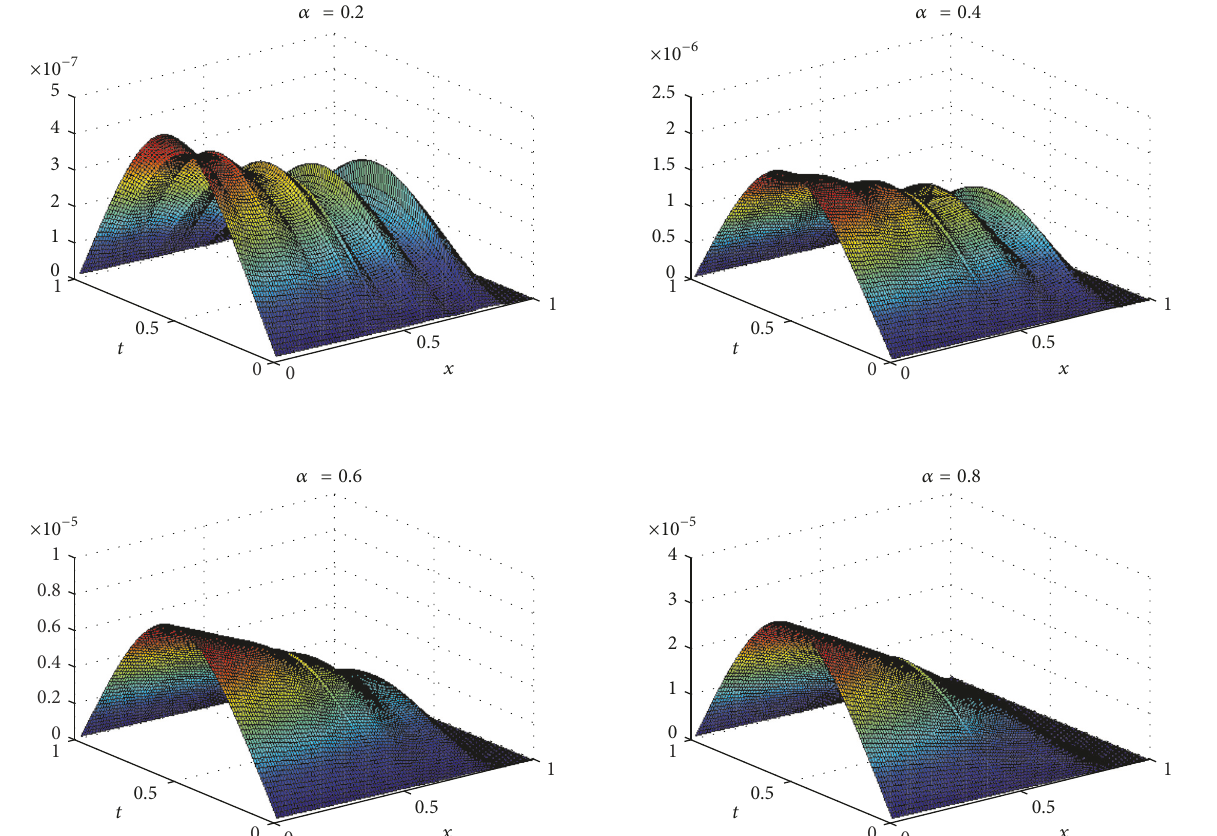
Figure 1: Error planes for 𝜏 = ℎ = 1/100 for different 𝛼 in Example